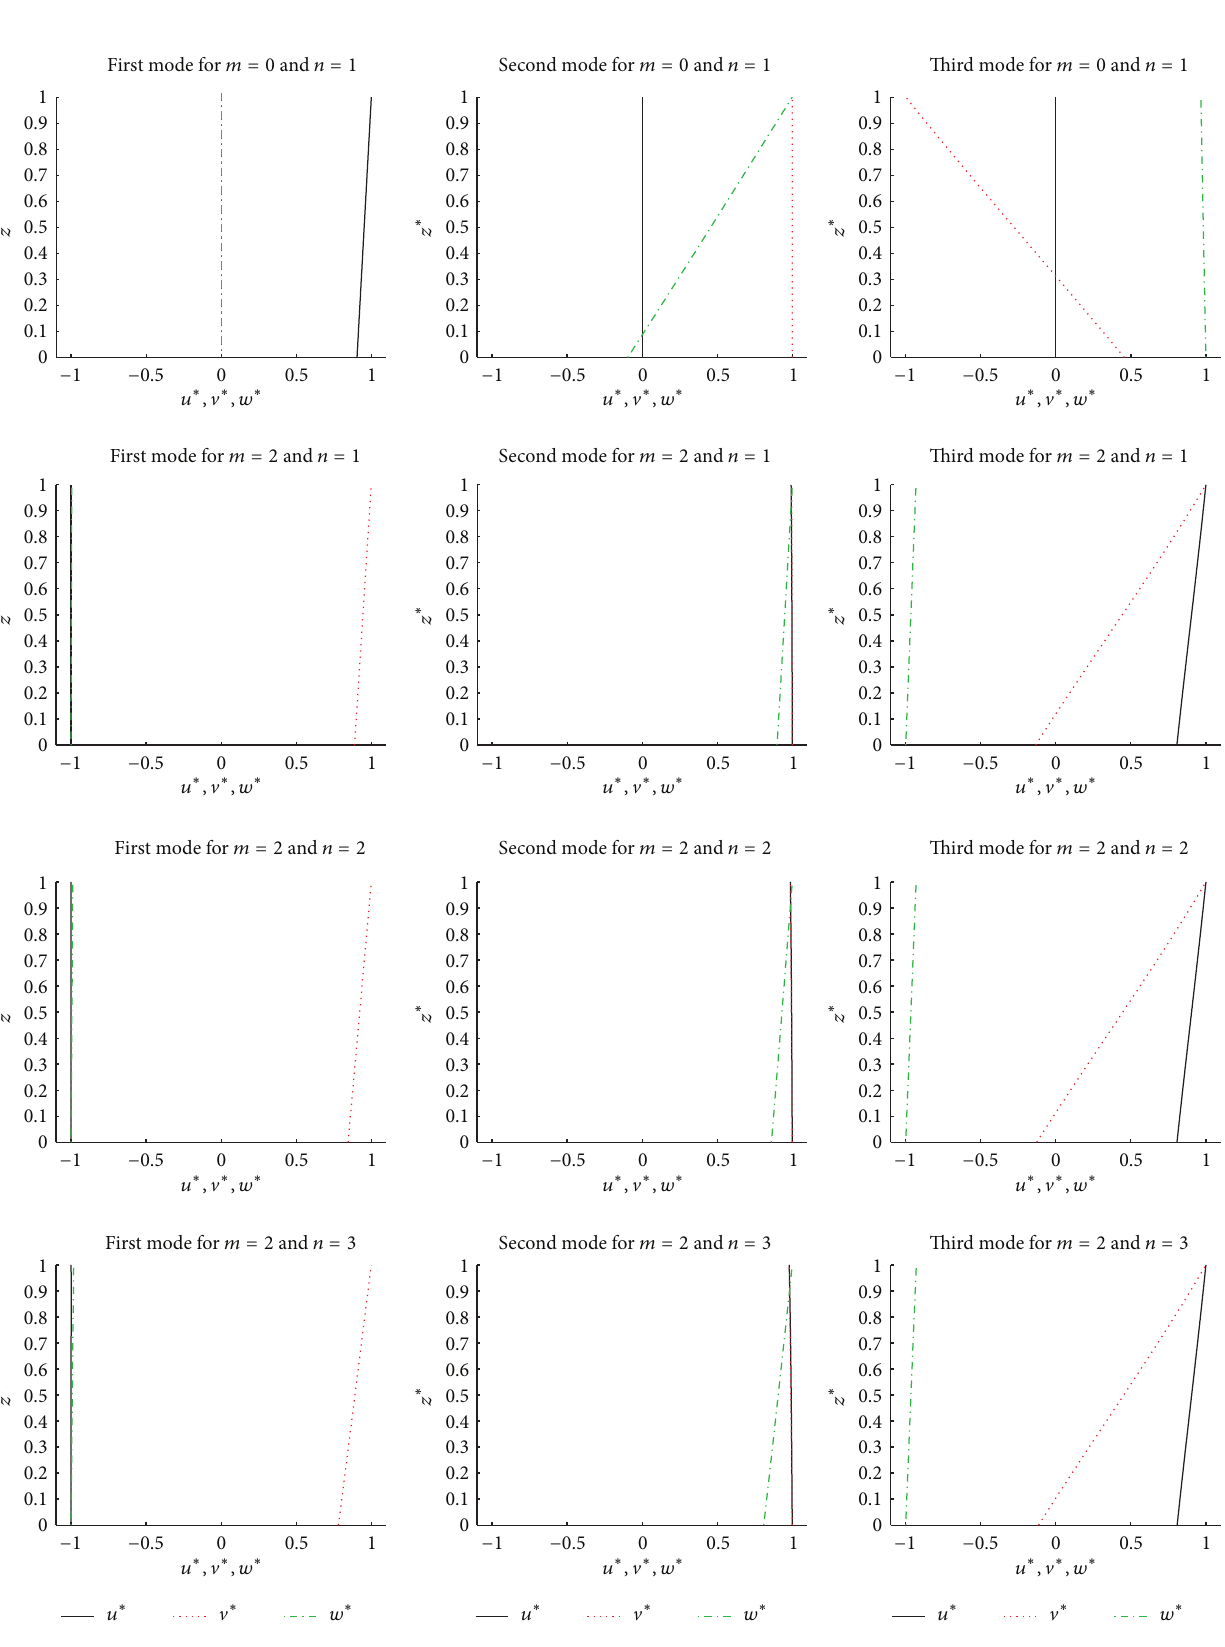
Figure 8: Benchmark 8, simply supported orthotropic cylinder (𝜃 = 0 ∘ ). First three vibration modes in terms of displacement components through the thickness for thickness ratio 𝑅 𝛼 /ℎ = 10 and several combinations of half-wave